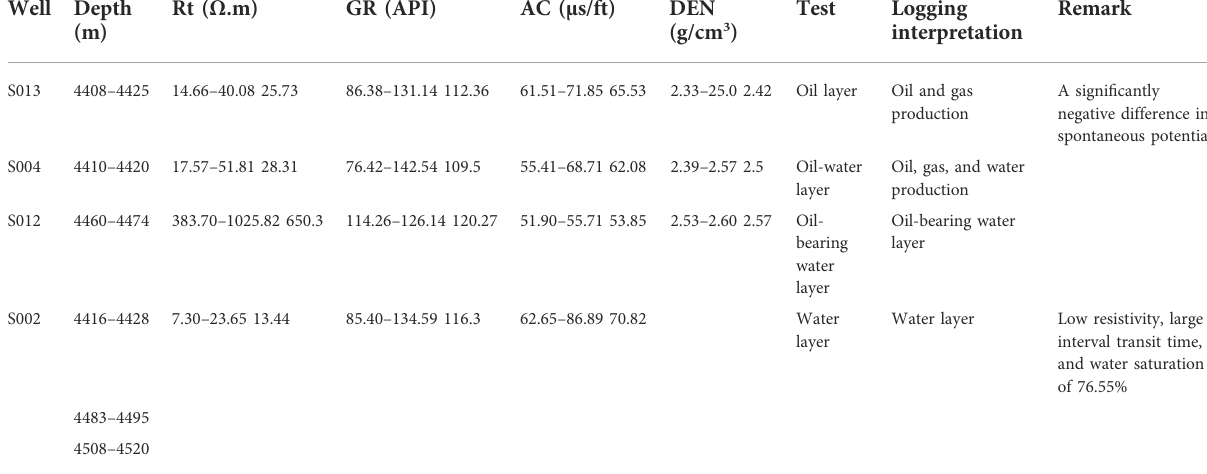
TABLE 2 Relationship between the electrical property and oil-bearing property of the main exploration well. Well Depth (m)